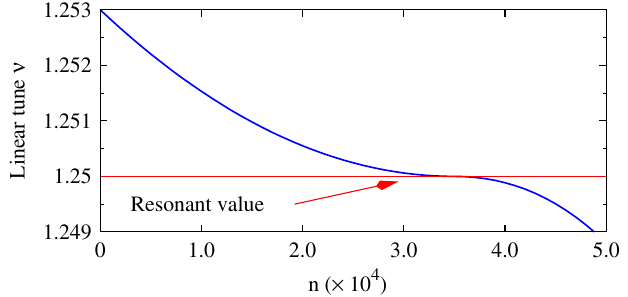
FIG. 4. (Color) Tune variation used for the splitting presented in Fig. 3. The tune curve is of type 2 (cid:1) 3 .